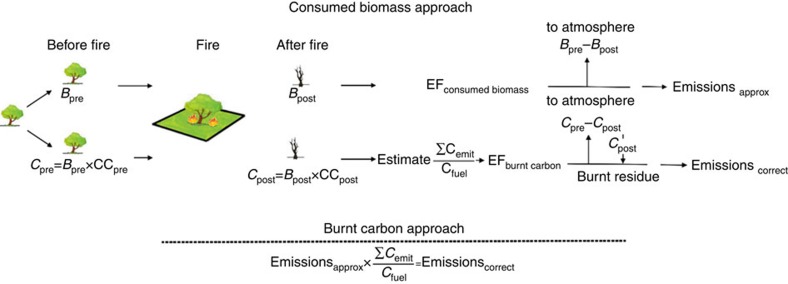
A diagrammatic illustration of how biased emission estimates from fire occur.A schematic of the two different ways the carbon mass balance technique has been interpreted and applied in vegetation fire emission studies. Cpre and Bpre denote pre-fire carbon and biomass fuel, CCpre and CCpost represent pre- and post-fire carbon content, and Cpost and Bpost denote post-fire carbon and biomass fuel, respectively. ΣCemit/Cfuel represents the correction factor required for the burnt carbon accounting framework. Emissionsapprox represents approximate emissions estimated using the consumed biomass approach and Emissionscorrect represents emission estimates using the burnt carbon approach. EF denotes emissions factor with the estimate depending on what accounting framework is used (that is, consumed biomass or burnt carbon).